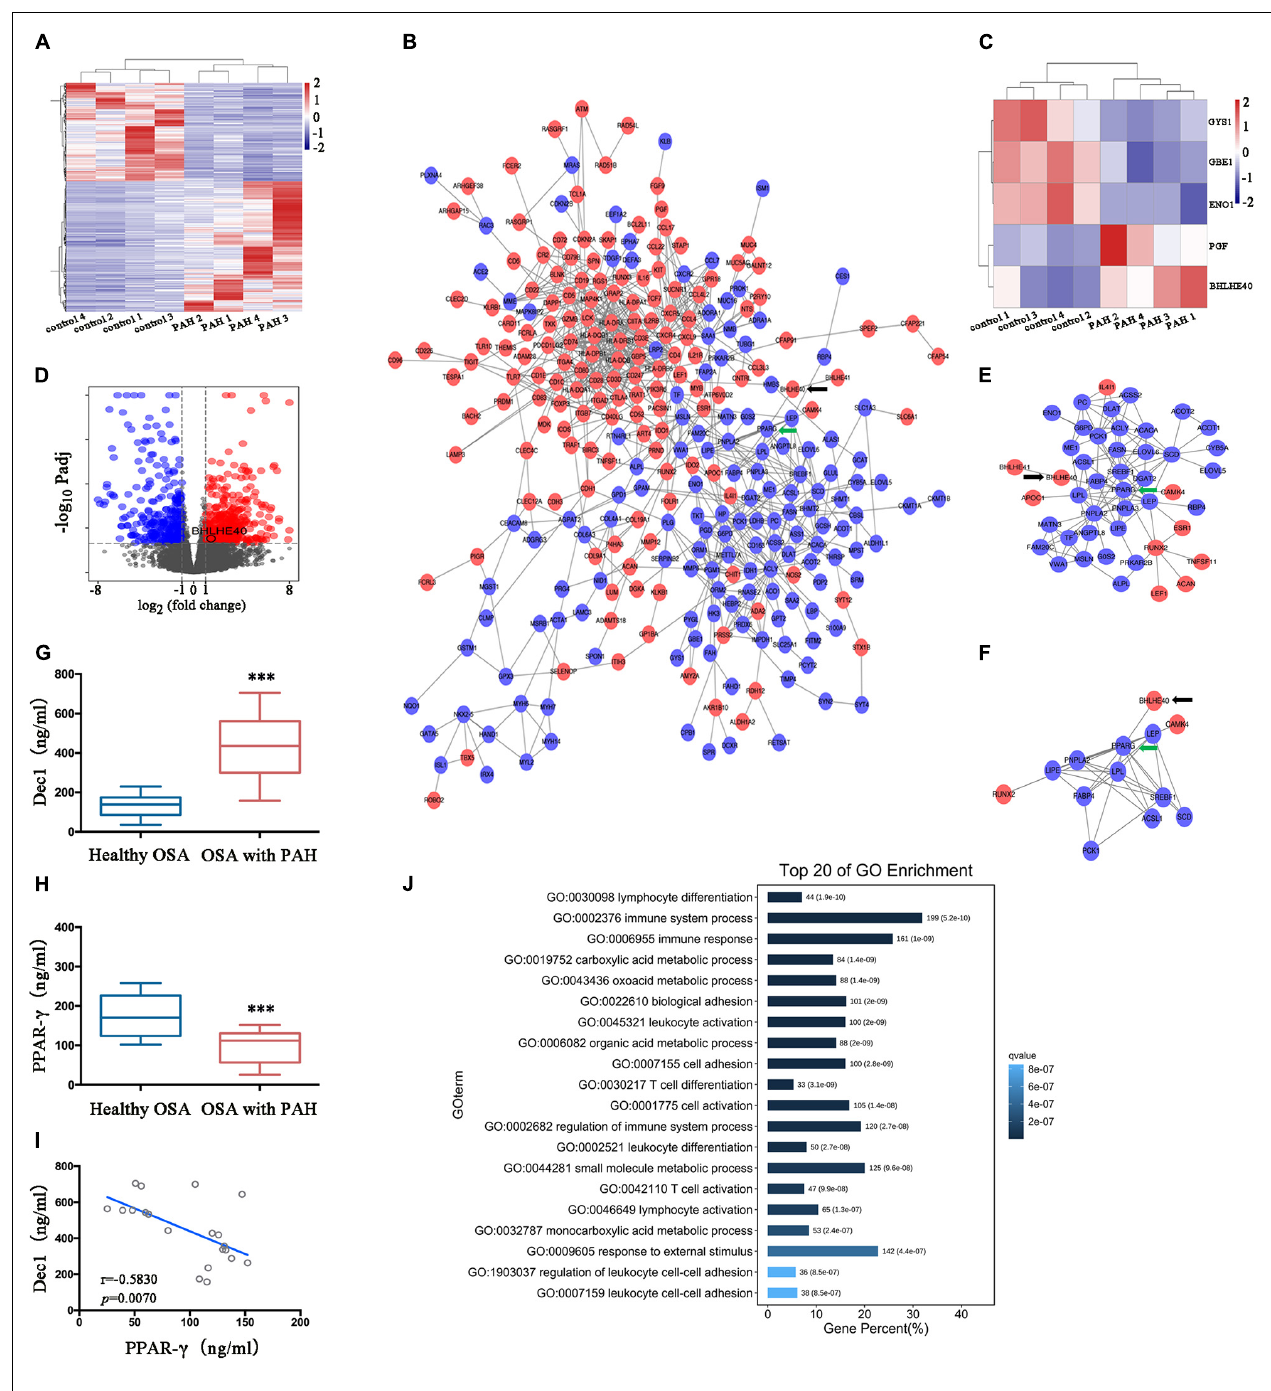
FIGURE 1 | The differentiated embryo-chondrocyte expressed gene 1-peroxisome proliferative activated receptor- γ (Dec1-PPAR γ ) axis is dysregulated in patients with PAH. (A) The heatmap of differentially expressed genes (DEGs) in patients with pulmonary arterial hypertension (PAH) from the GSE84538 database. (B) The protein-protein interactions (PPI) network of the DEGs. Black and green arrows indicate BHLHE40 (also named Dec1) and PPAR γ , respectively. (C) The heatmap of the differentially expressed hypoxia-related genes in patients with PAH from the GSE84538 database. (D) The volcano plot showed the DEGs (upregulated in red and downregulated in blue) in patients with PAH from the GSE84538 database. (E,F) The PPI networks based on BHLHE40 (arrowed as black) and PPAR γ (arrowed as green), respectively. (G,H) Plasma protein levels of Dec1 (G) and PPAR γ (H) were determined by Enzyme-linked immunosorbent assay (ELISA) in obstructive sleep apnea (OSA) patients with or without PAH. One-way ANOVA tests were applied for statistical analysis. (I) Spearman’s correlation analysis was performed to evaluate the correlations between Dec1 and PPAR γ expressions in OSA patients combined with PAH. (J) The top 20 entries of the GO enrichment analysis of the gene set. ∗∗∗ p <